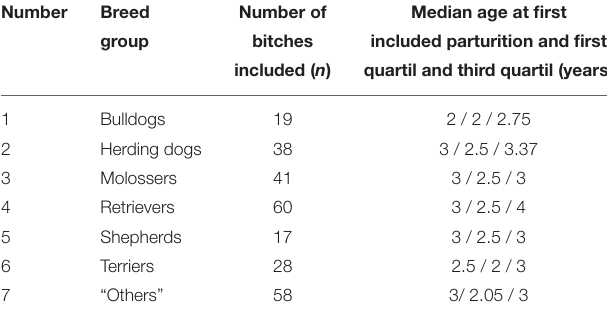
TABLE 1 | Included breed